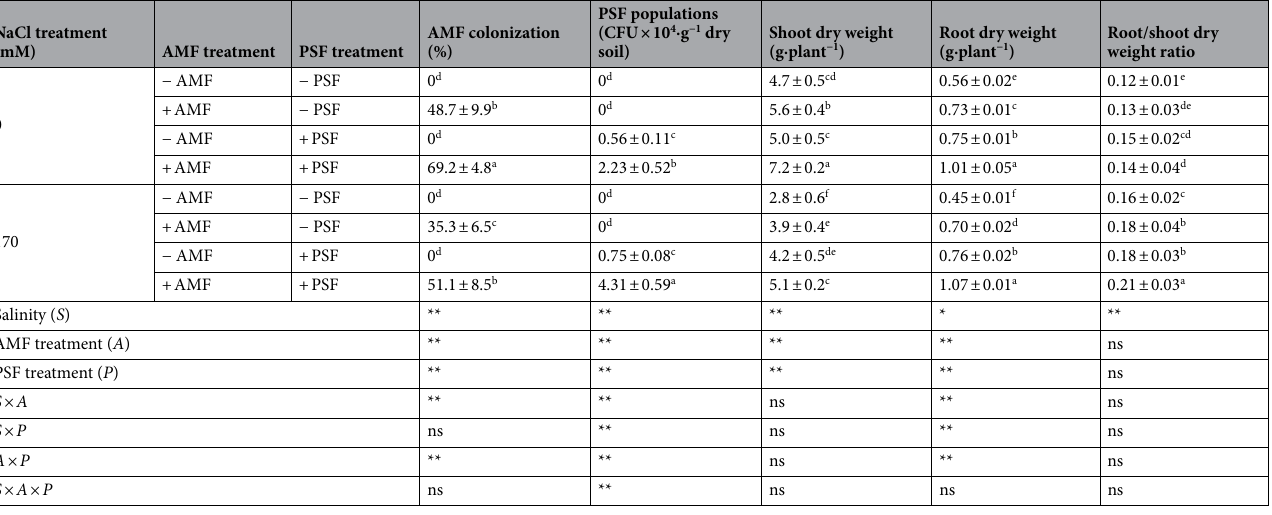
Table 1. Effects of F. mosseae and/or A. spartima on arbuscular mycorrhizal fungi (AMF) colonization, phosphate-solubilizing fungus (PSF) populations, and growth parameters of beach plum under saline and non- saline conditions. Data are means ± SE of three replicates. The values of each parameter labeled by different letters indicate significant differences assessed by Duncan’s test after performing a three-way MANOVA ( p < 0.05). ns non-significant; *significant at p < 0.05; **significant at p <